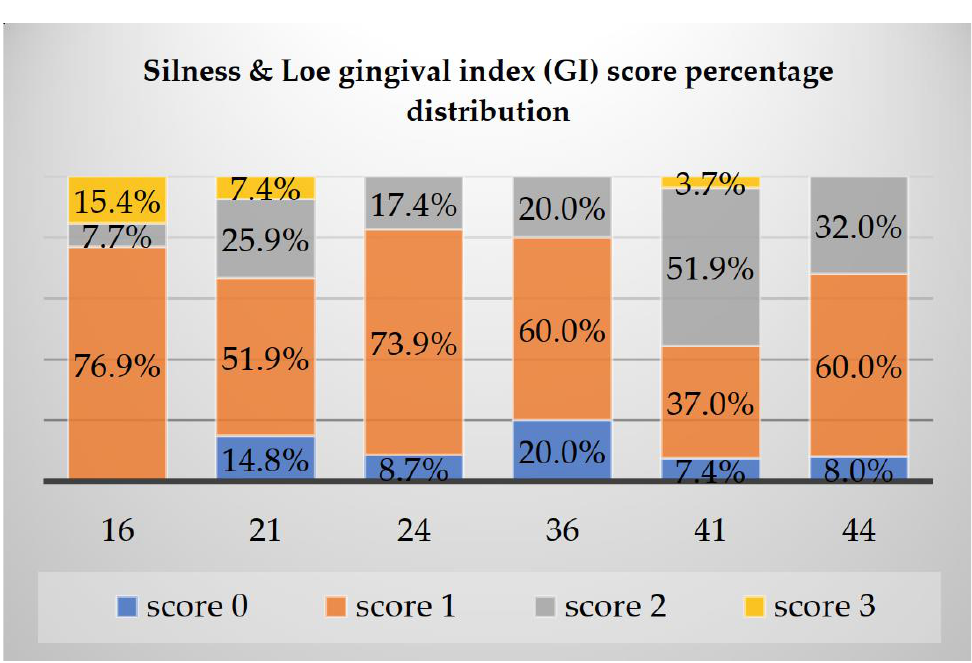
Figure 1. Sillness and Loe gingival index mean score percentages distributions on Ramfjord teeth (teeth numbers 16, 21, 24, 36, 41 and 44).